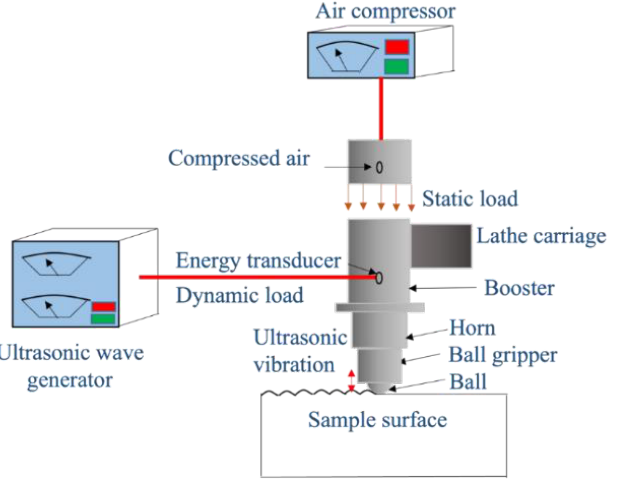
Figure 17. Schematics of the UNSM process. The mechanical impacts were applied on the specimen surface using a spherical roller tip of tungsten carbide and alumina. The repeated high-frequency impacts of the hard spherical tip on the specimen surface develop SPD, leading to surface nanocrystallization, introducing the high amount of RCS, developing high-density dislocations, and GNS layer [44]. The high-frequency ultrasonic vibrations are produced using an ultrasonic generator, which is amplified using a booster with the help of a horn and probe. The SPD developed during the UNSM process depends on the input parameters, such as static load, number of strikes, and roller diameter. Proper selection of these input param- eters can control the GNS layer thickness. In the UNSM process, the primary function of the spherical roller tip is to create a mechanical impact and produce the SPD. In the case of USRP, the primary function of the spherical roller tip is to perform DR. Scholars adopted UNSM techniques on different steel grades [90–94], titanium alloys [95–98], alu- minum alloys [99–101], and magnesium alloys [102,103], nickel alloys [89,104], copper alloys [105,106], shape memory alloys [107,108] high entropy alloys [109–111] and thus observed a significant enhancement in surface mechanical properties and surface integrity. In addition, there are advancements in USNM techniques, such as electropulsing-assisted UNSM and laser-assisted UNSM [112,113]. Scholars used combination techniques along with UNSM for superior enhancement in the surface mechanical properties